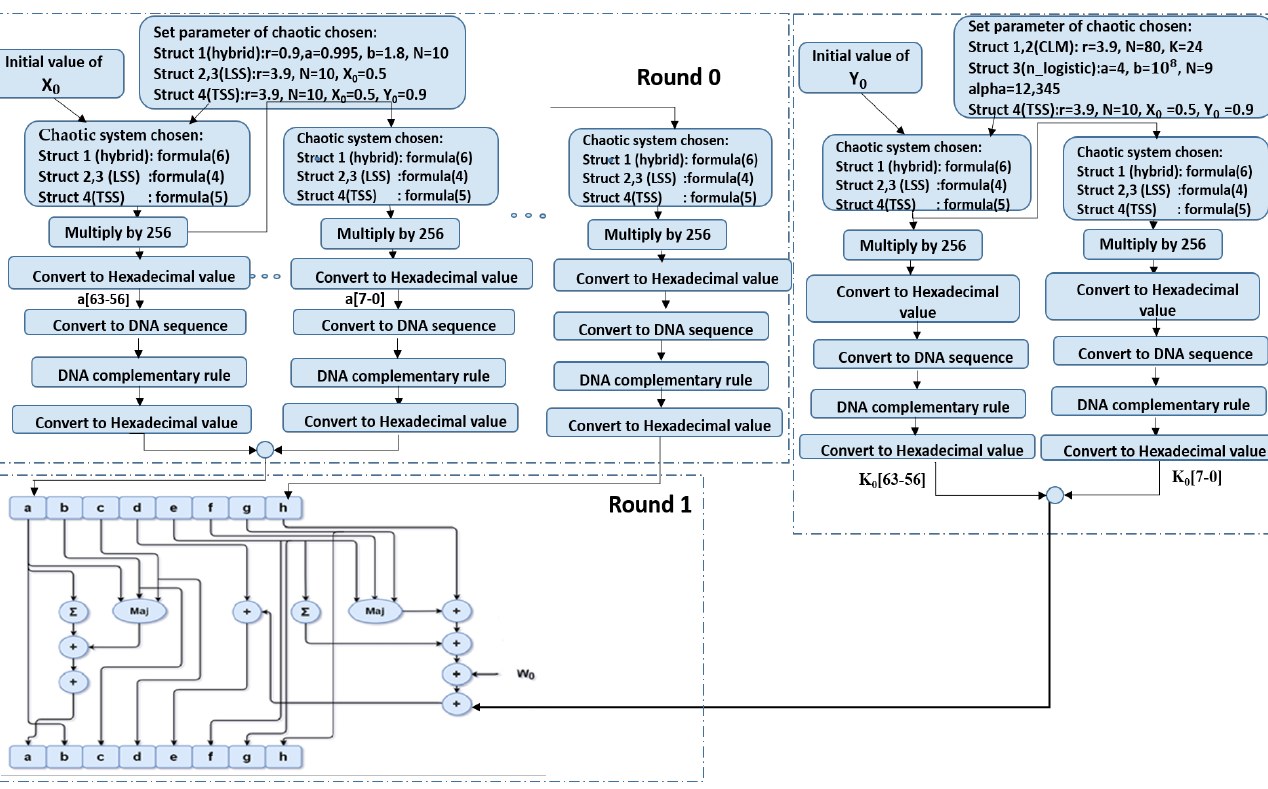
Figure 8. Proposed Hash-512.